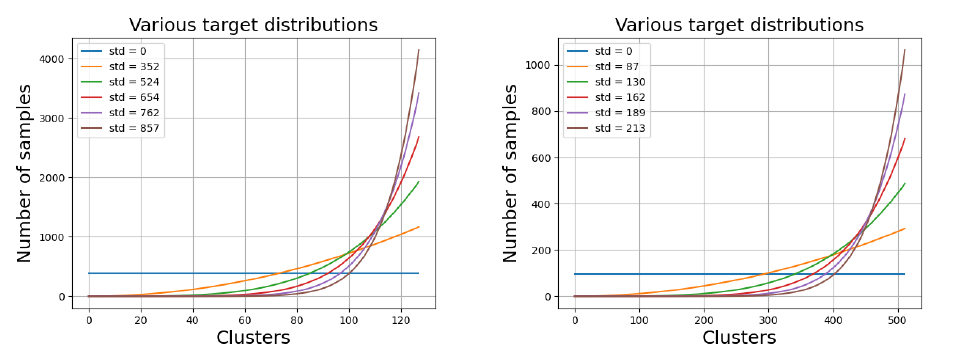
Figure 3. Left: various target distributions of pseudo-labels for dataset CIFAR-10; Right: various target distributions of pseudo-labels for dataset